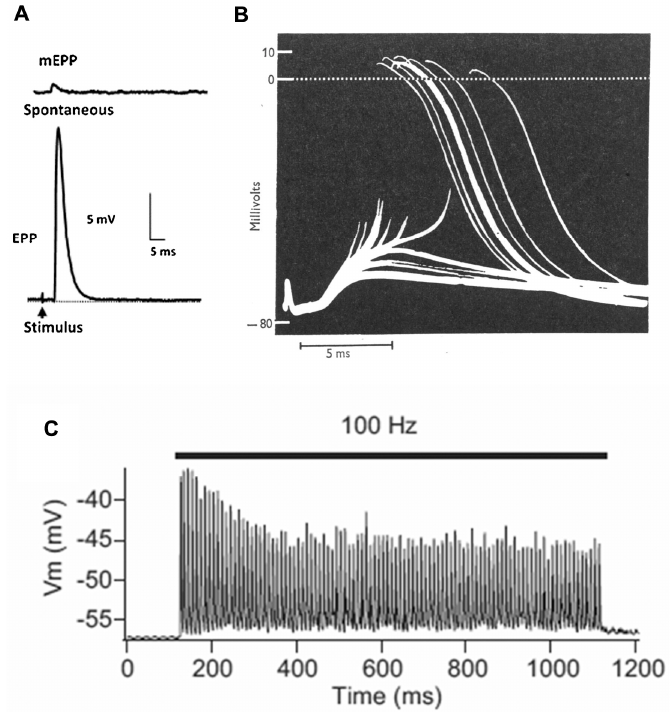
Figure 2. Basics of neuromuscular transmission. ( A ) Intracellular recordings of synaptic events at a mouse NMJ: top , miniature endplate potential (mEPP), the response to a single quantum of ACh; bottom , plate potential (EPP), the nerve-evoked response to about 50 quanta; ( B ) Intracellular recordings from an NMJ from a human patient with myasthenia gravis. The smaller events are subthreshold EPPs, which result from the low numbers of AChR in this disease. (From Elmqvist et al., 1964, with permission) [5]. The large events, of nearly constant amplitude, are mAPs evoked by those EPPs that reach threshold; ( C ) A train of EPPs at a mouse EPP in which the muscle cell action potential (mAP) is blocked with µ -conotoxin. During stimulation at 100 Hz, there is a decline in EPP amplitude. (Adapted from Ruiz et al., 2011, with permission) [6]. However, in the absence of the toxin, the EPPs would all be large enough to trigger